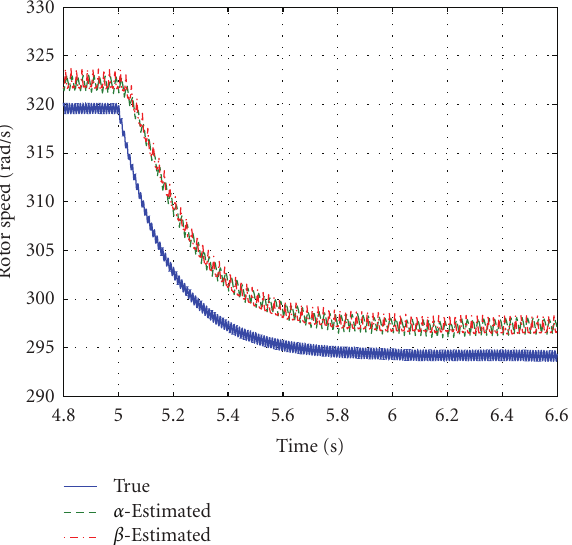
Figure 10: Rotor speed ω r and its estimations (cid:6) ω rα and (cid:6) ω rβ for 50Hz during the application of a load step (computational simulation).